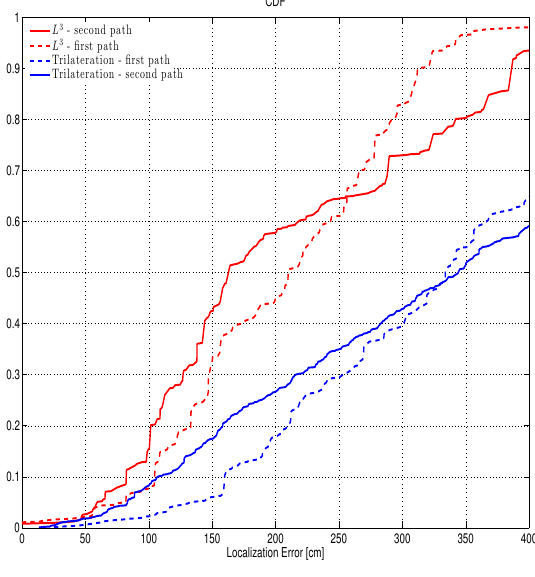
Figure 7. Cumulative Distribution Function (CDF) of the localization error: actual performance of both the L 3 and common trilateration algorithms, i.e. , with and without the use of a predictive system, respectively.